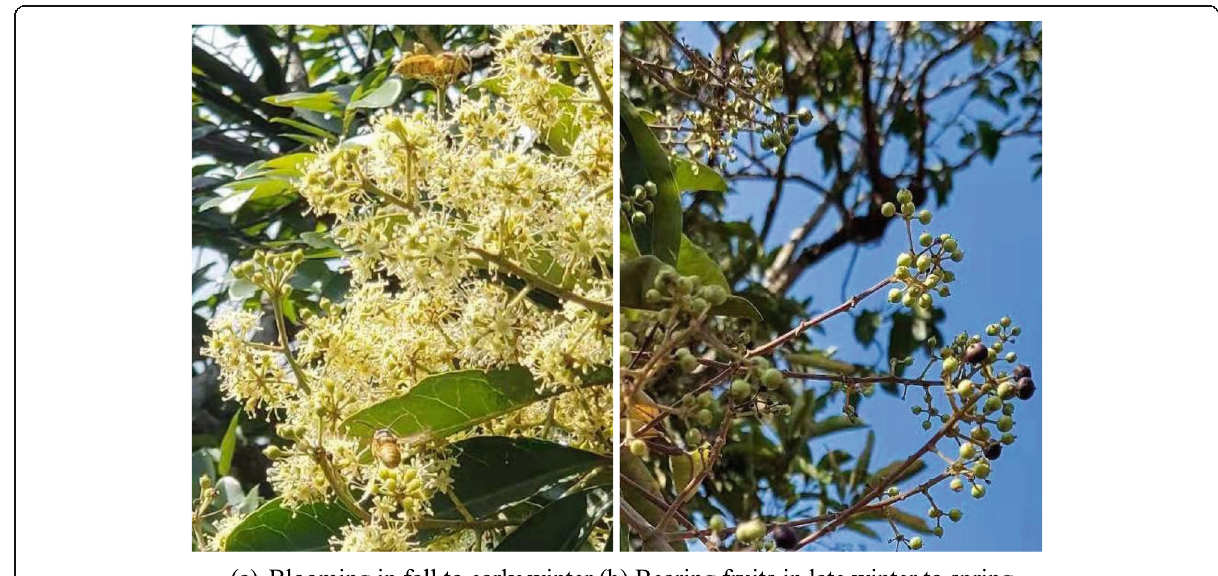
Fig. 12 An example of native tree ( Schefflera heptaphylla) that provide rich ecological services to local insect pollinators and